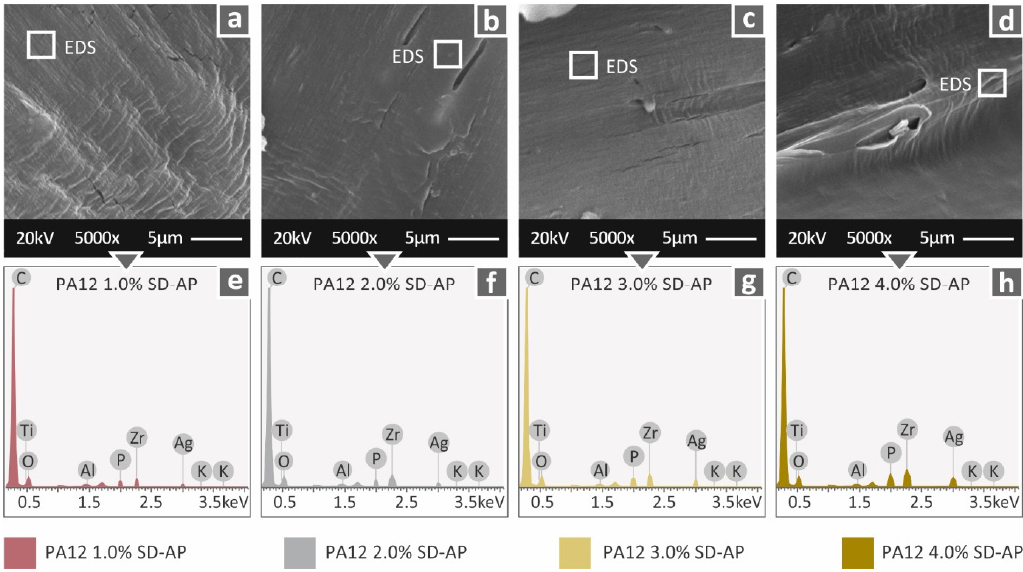
Figure 10. Fracture area SEM images of ( a ) PA12/AgDANP 1.0 wt.%; ( b ) PA12/AgDANP 2.0 wt.%; ( c ) PA12/AgDANP 3.0 wt.%; ( d ) PA12/AgDANP 4.0 wt.%; and ( e – h ) corresponding EDS analysis.